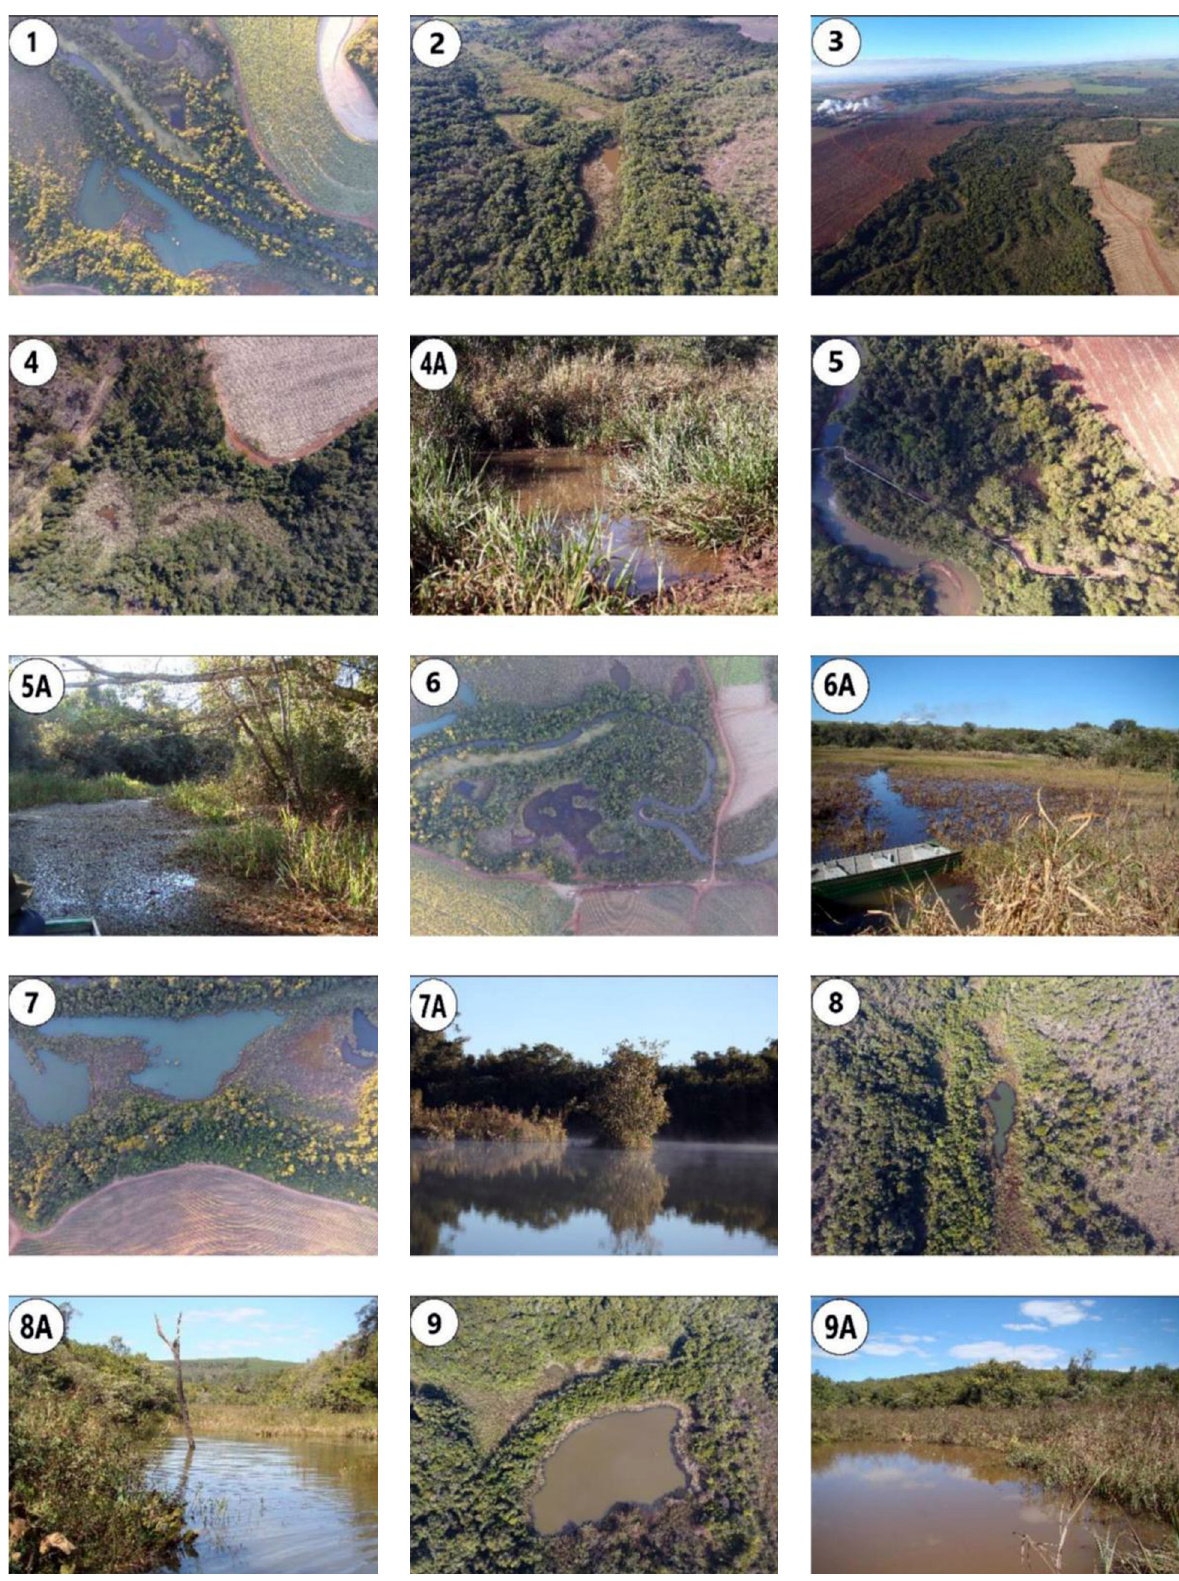
Table 1. Photos by Hatus Siqueira (1, 2, 3, 4, 5, 6, 7); Tâmer Faleiros (4A, 5A, 6A, 7A, 8, 8A, 9,